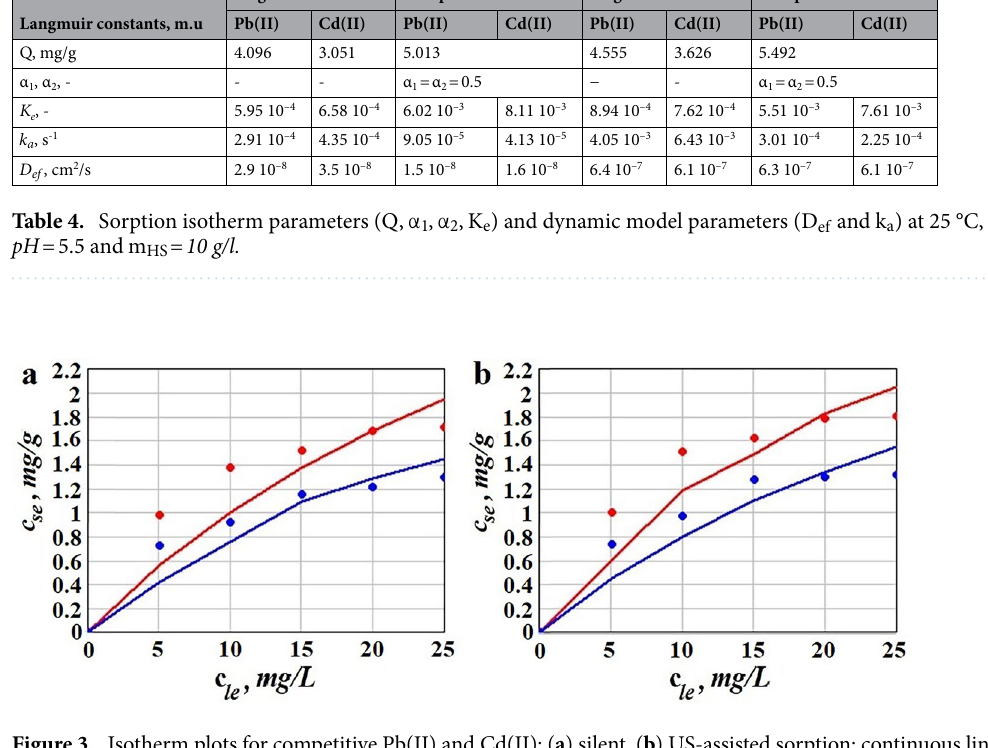
Figure 3. Isotherm plots for competitive Pb(II) and Cd(II): ( a ) silent, ( b ) US-assisted sorption; continuous line obtained using Eqs. (13,14), points represent experimental data at 25 °C; red colour is for Pb(II), blue for